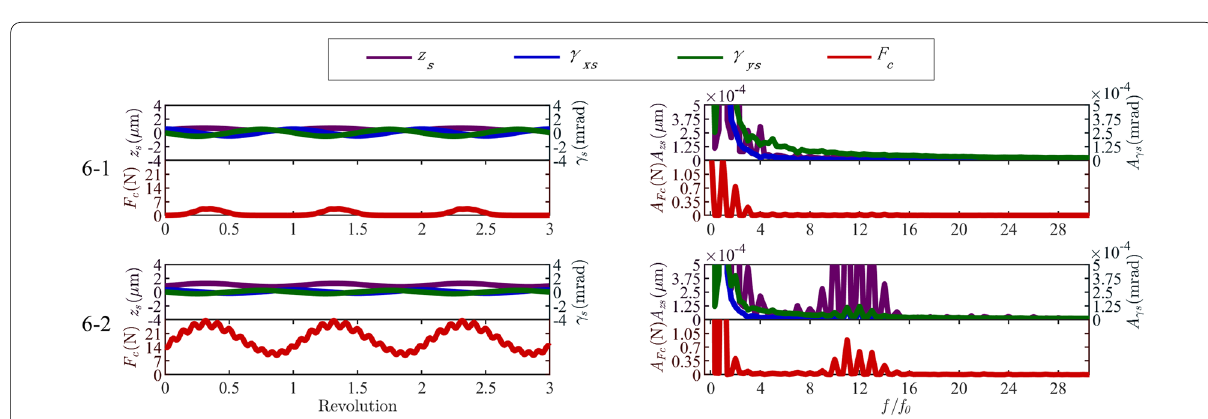
Figure 11 Results with other face designs (Group 6)